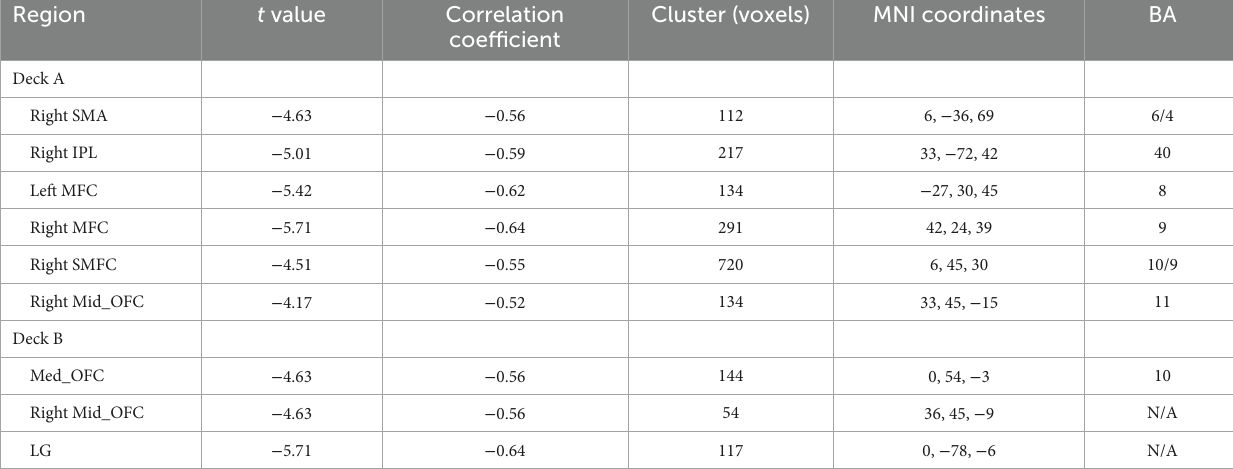
Cluster (voxels) MNI coordinates BA coefficient